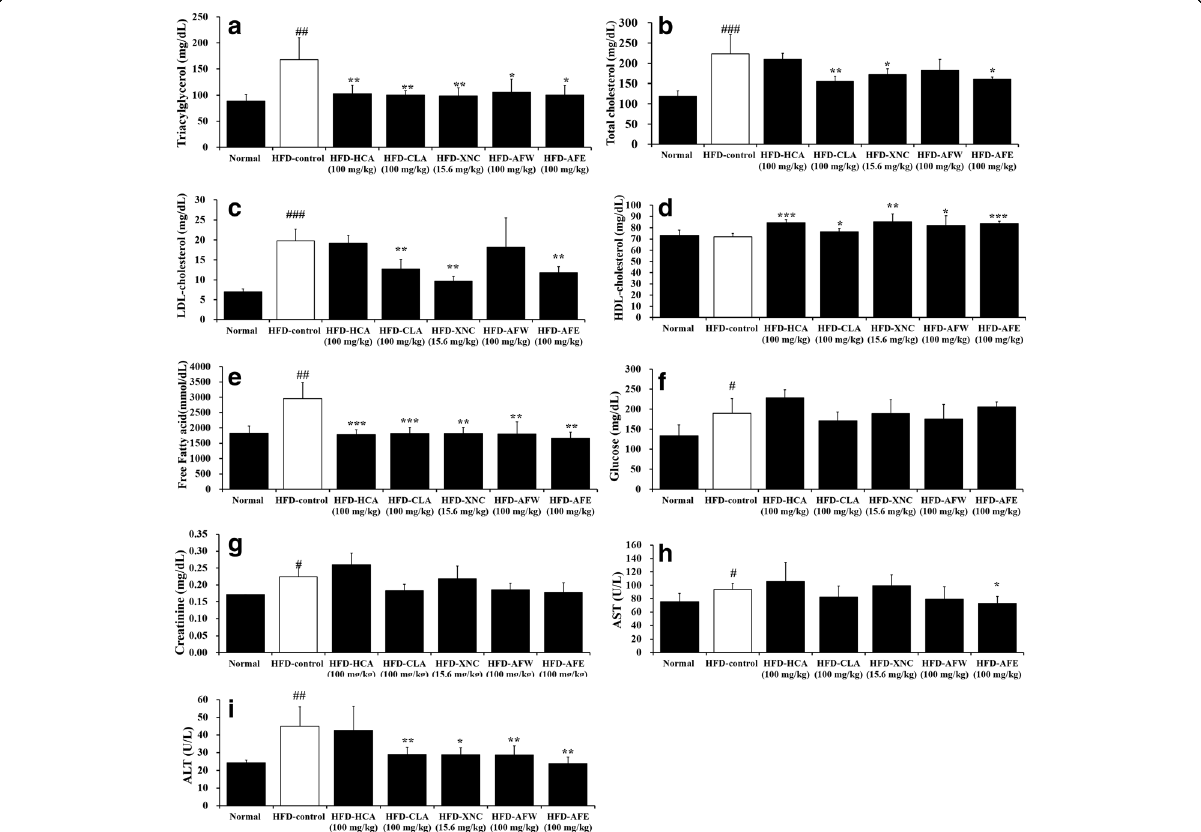
Fig. 3 Effect of 6-week treatment with Allium fistulosum aqueous extract (AFW) and A. fistulosum ethanolic extract (AFE) on blood lipid and glucose levels and liver enzymes in high-fat diet (HFD)-induced obese mice. a Triacylglycerol, ( b ) total cholesterol, ( c ) LDL-cholesterol, ( d ) HDL-cholesterol, ( e ) free fatty acids, ( f ) glucose, ( g ) creatinine, ( h ) aspartate transaminase (AST), and ( i ) alanine transaminase (ALT) levels. Normal, standard chow; HFD- control, HFD only; HFD-HCA, HFD plus 100 mg/kg Garcinia cambogia extract containing hydroxycitric acid; HFD-CLA, HFD plus 100 mg/kg conjugated linoleic acid; HFD-ORL, HFD plus 15.6 mg/kg Xenical (orlistat); HFD-AFW, HFD plus 100 mg/kg AFW; HFD-AFE, HFD plus 100 mg/kg AFE. Results are expressed as the mean±standard error of the mean (SEM) ( n =6). # p <0.05, ## p <0.01, ### p <0.001 compared with the normal control group; * p <0.05, ** p <0.01, *** p <0.001 compared with the HFD-control